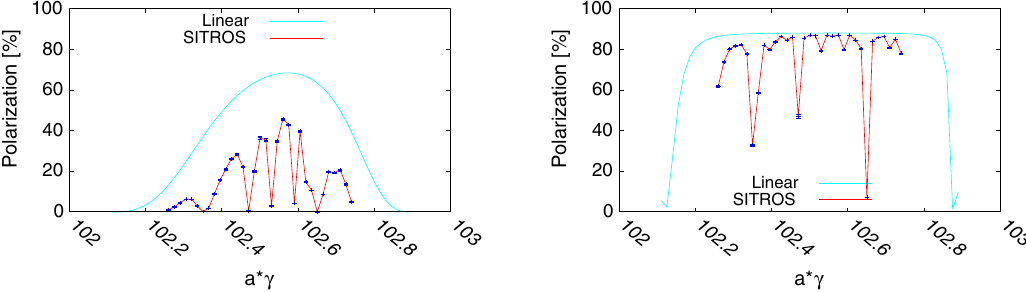
¼ 200 μ m and 10% y